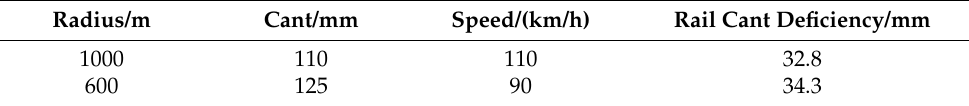
Table 3. Parameters of the curves.